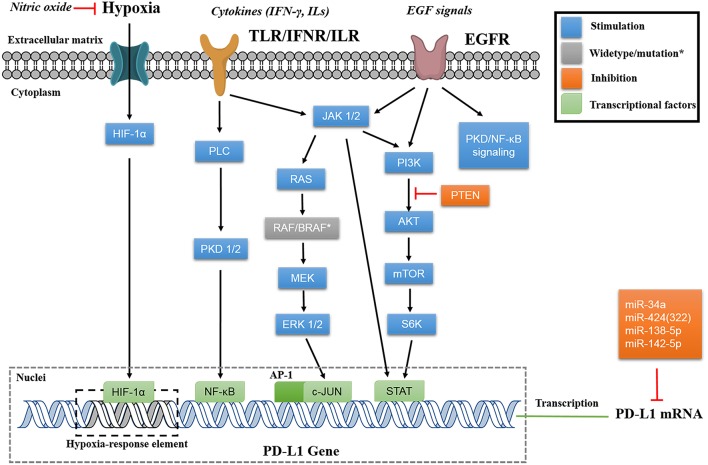
Signaling pathways of PD-L1 regulation. The instinct PD-L1 expression is regulated by translational factors (HIF-1α, NF-κB, AP-1, and STATs) that binds to the gene promoter. The extracellular signals (hypoxia, cytokines, and EGF signals) will be transduced via different pathways (mainly through MAPK or PI3K/AKT) to regulate PD-L1 expression on transcriptional level. Some miRs are able to bind to 3′-UTR of PD-L1 mRNA for post transcriptional regulation.